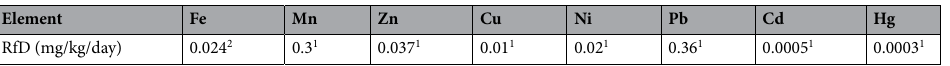
Table 13. Oral reference dose for risk elements. 1 According to FRAMEWORK 85 . 2 According to EPA 86 .